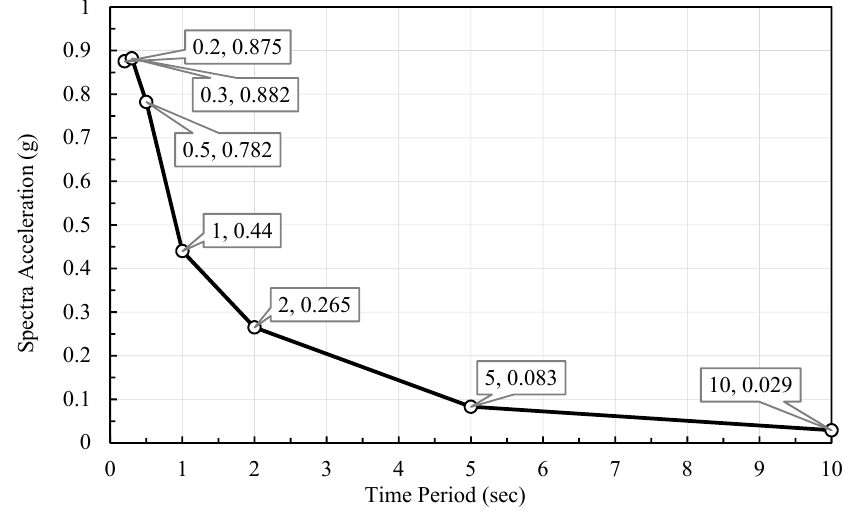
Figure 4. UHS for Vancouver based on TWB’s location.